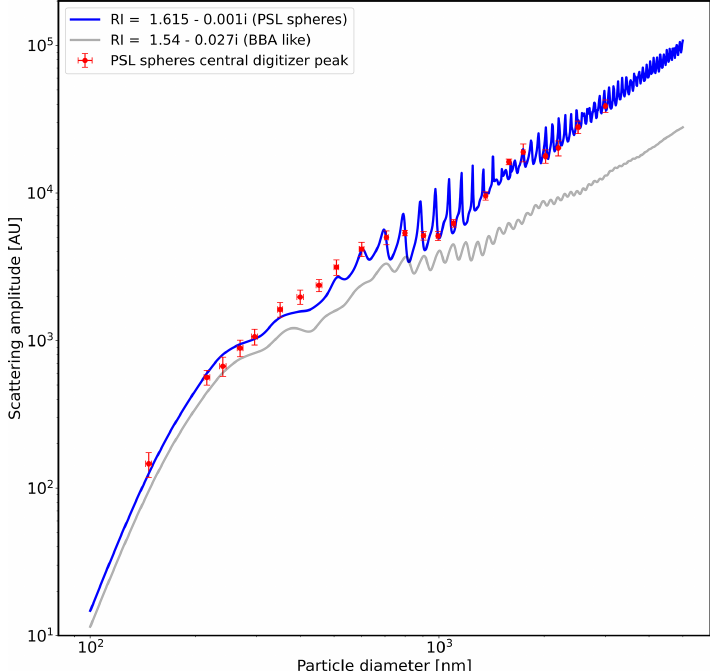
Figure A2. POPS scattering amplitudes for particles from 0.1 to 4µm. Calculations for the blue curve used the refractive index for PSL spheres and for the black curve a refractive index for biomass burning particles. The red points are the real scattering amplitudes measured during the calibration with PSL spheres. Both the blue and black curves have been scaled using the same scaling factor.